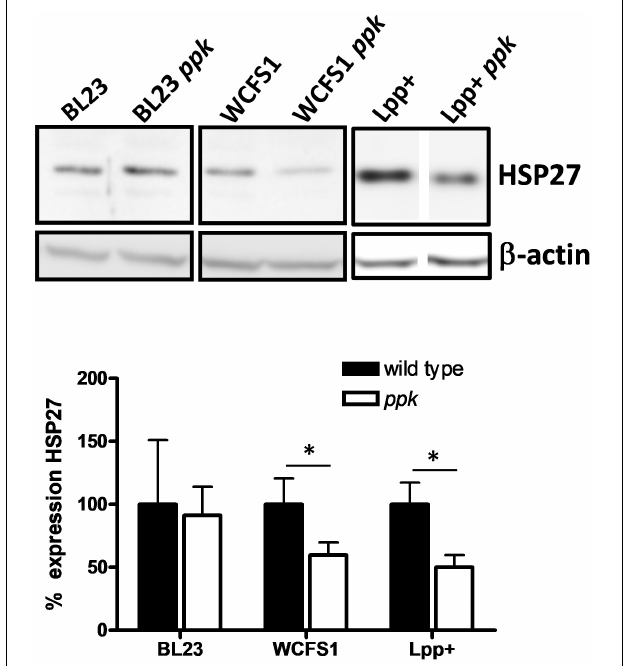
FIGURE 4 | Expression of HSP27 in Caco-2 cells. Monolayers of cultured Caco-2 cells were incubated with supernatants of different Lactobacillus and their ppk -derivatives and expression of HSP27 was determined by Western blot in crude extracts. Blots developed with anti- β -actin antibody were used as loading controls and they also served to normalize expression. Protein signals in the blots for each pair of strains come from the same gel. The graph below the blots shows the relative HSP27 expression from three replicates (expression in wild-type strains set at 100%). Asterisks indicate a significant difference between wild type and ppk strains ( p <